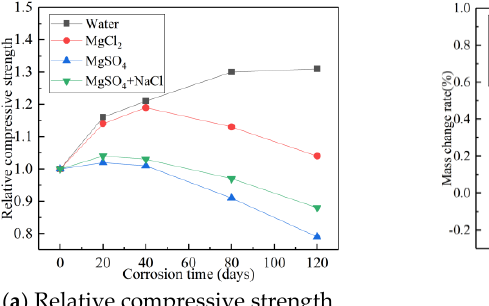
Figure 5. Influences of SO 4 2− on the Physical Properties of MK Concrete.